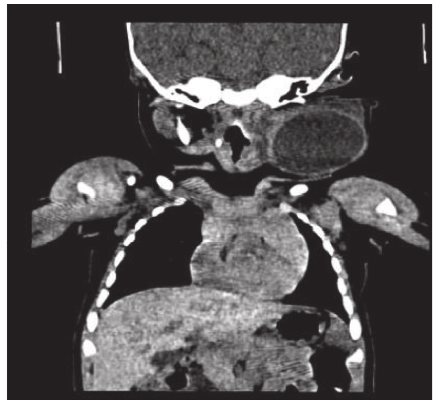
Figure 3: Coronal computed tomography showing left cervical cystic hygroma.